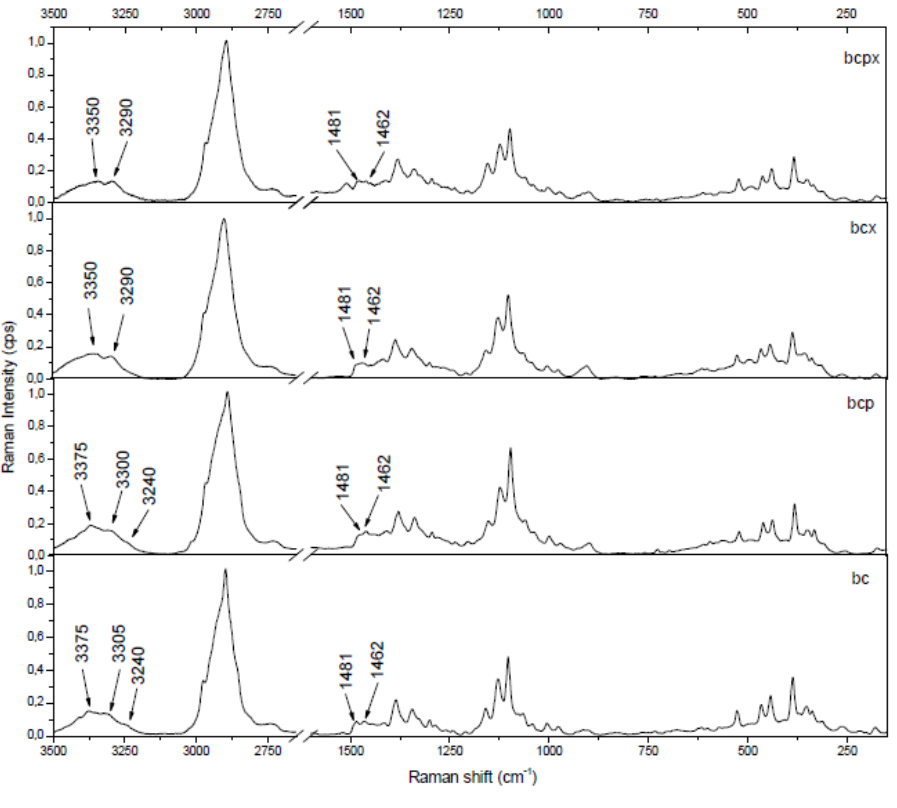
Figure 3. Comparison of bacterial celluloses cultured in presence of pectin (BCP), xyloglucan (BCX), both (BCPX) or neither (BC) Raman spectra in the 3,500–2,600 and 1,600–150 cm −1 range.